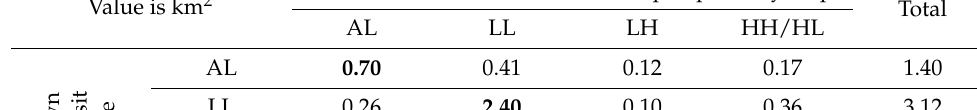
Table 9. Sensibility and specificity results of RF and KNN prospectivity models. The best performing metric values that were calculated per class is shown in bold type.